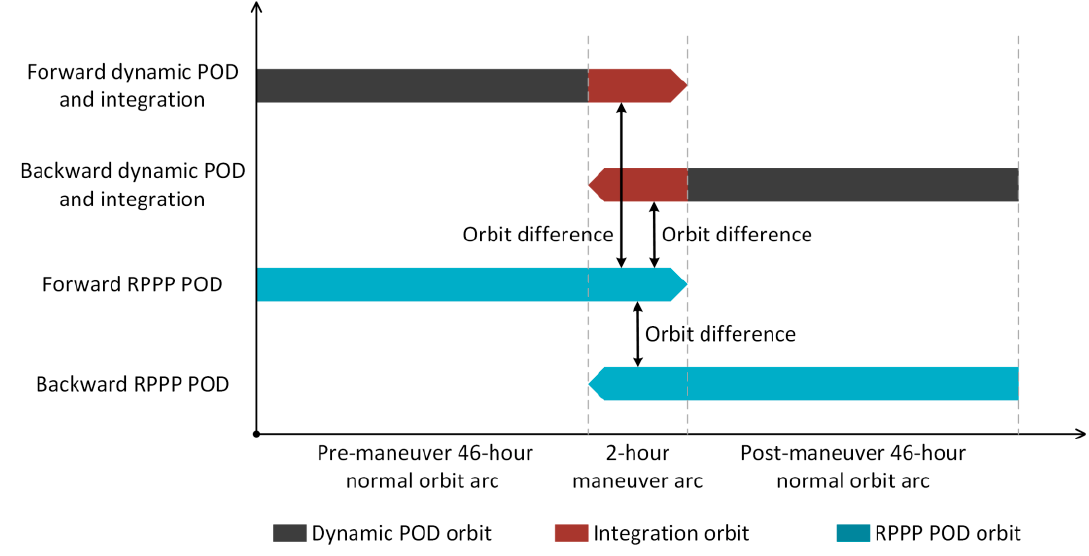
Figure 6. Computation and comparison strategy for the maneuvering satellites.